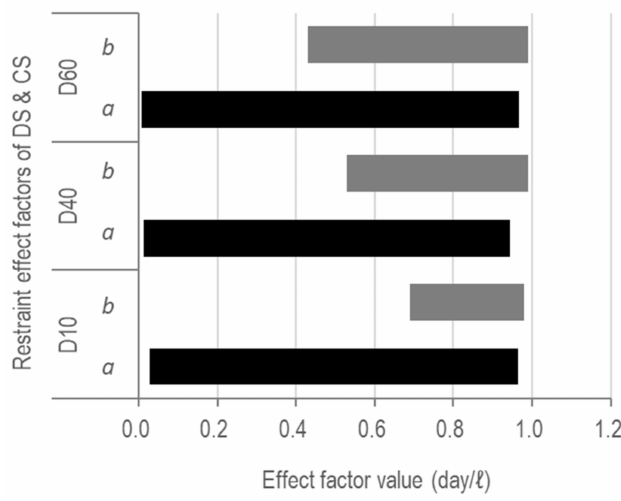
Figure 16. Analysis results of restraint effect factor of DS and CS (W160 mixtures); a is the restraint effect factor of DS and b is the restraint effect factor of